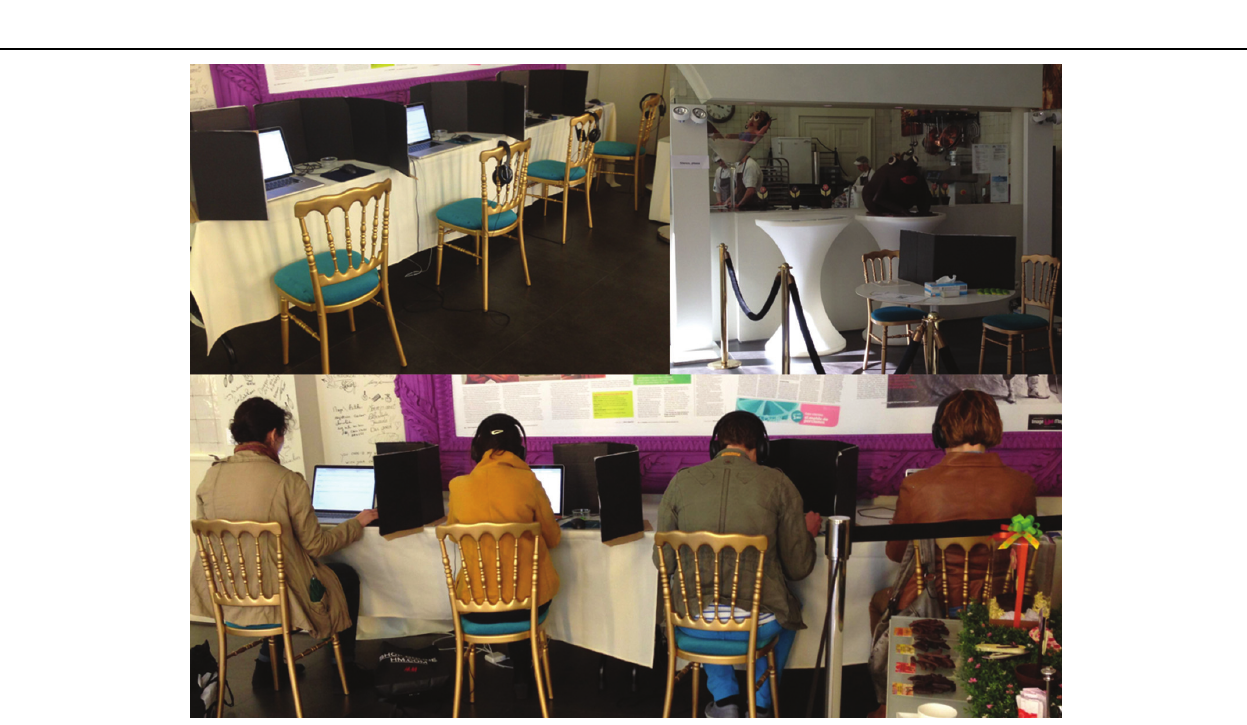
FIGURE 3 | Experimental booths prior to the experiment (top left), overview of the kitchen when entering the experimental area (top right) and overview of the experimental booths during the experiment (bottom).